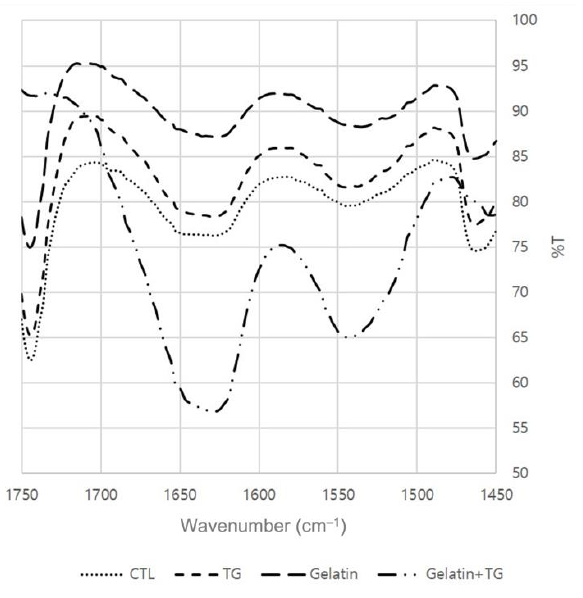
Figure 6. FTIR of restructured ham with gelatin and